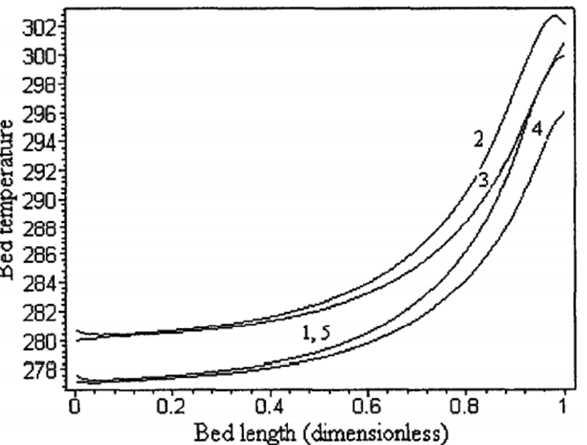
Figure 33. Temperature evolution profile (in K) as a function of the bed length dependently of the period of the AMRR cycle: ( 1 ) represent the beginning of the last AMRR complete cycle, ( 2 ) adiabatic magnetization, ( 3 ) hot blow, ( 4 ) adiabatic demagnetization, and ( 5 ) cold blow [116].